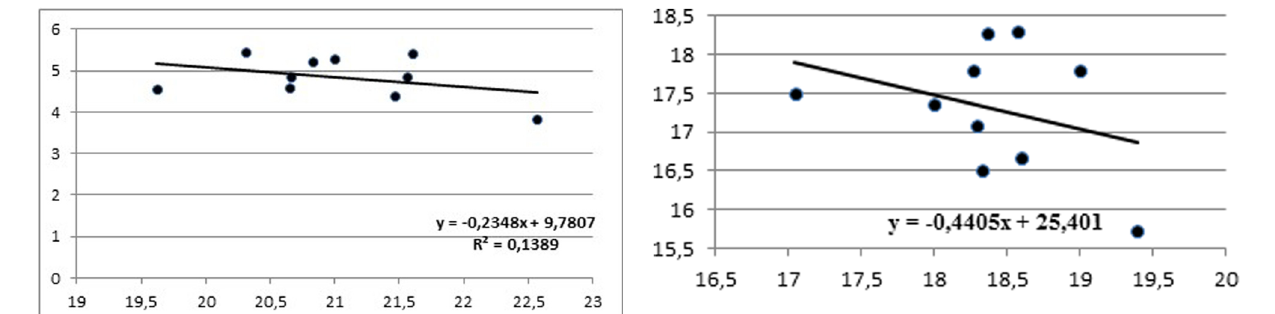
Figure 8: Linear approximation of the dependence of meat content on pre - slaughter weight in the cervical - scapular third of the carcass.